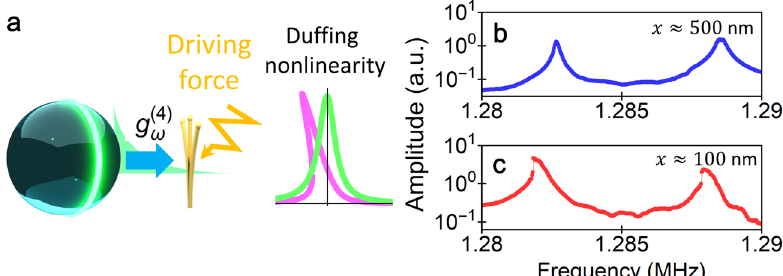
Fig. 6 Optically induced Duf fi ng nonlinearity. a Conceptual illustration of optically induced Duf fi ng nonlinearity via the static fourth-order optomechanical coupling. The purple spectral shape shows the typical Duf fi ng response in contrast to the green Lorentz response. Two-mode mechanical amplitude achieved in the driven lock-in measurement at x ≈ 100 nm (blue) ( b ) and x ≈ 500 nm (red) ( c